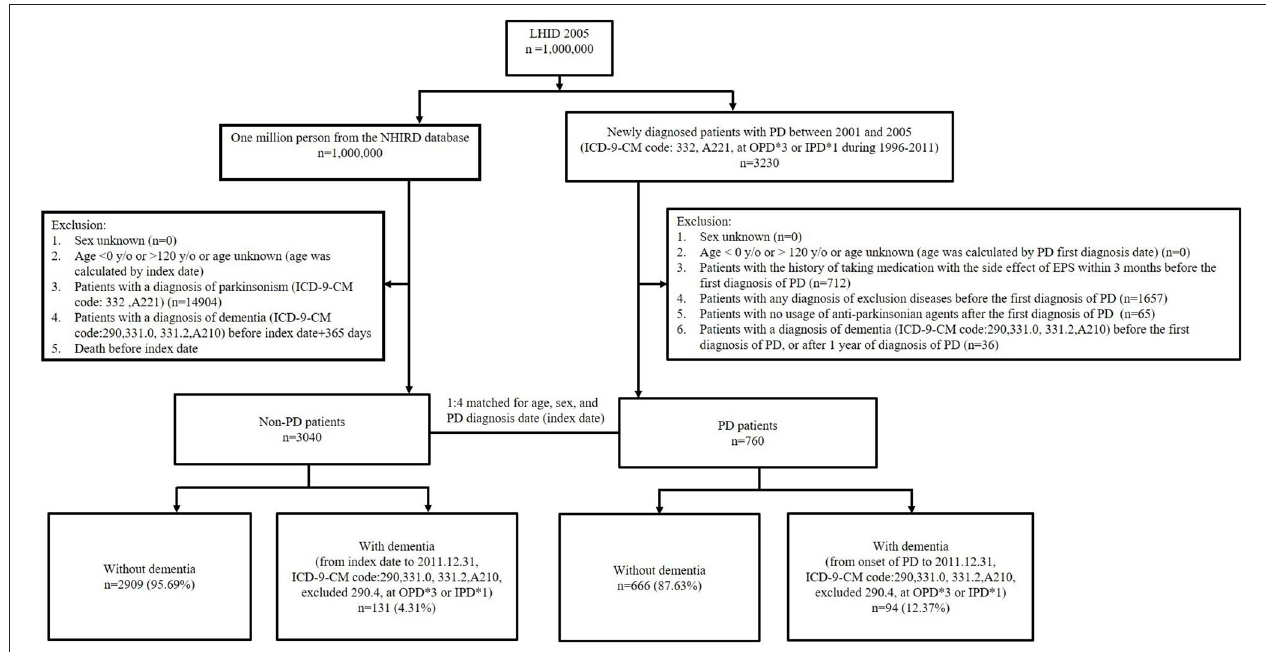
FIGURE 1 | Flow diagram for study participants. LHID, Longitudinal Health Insurance Database; NHIRD, National Health Insurance Research Database; PD, Parkinson’s disease; OPD, outpatient department; IPD, inpatient department; EPS, extrapyramidal